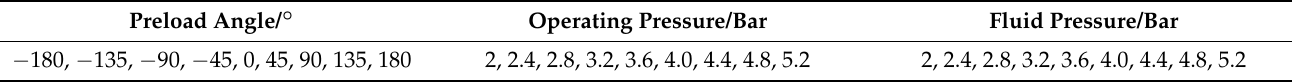
Table 1. Values of the input